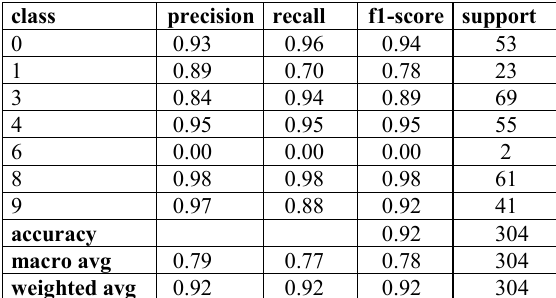
Table 8. Accuracy metrics calculated for pixel-based approach.